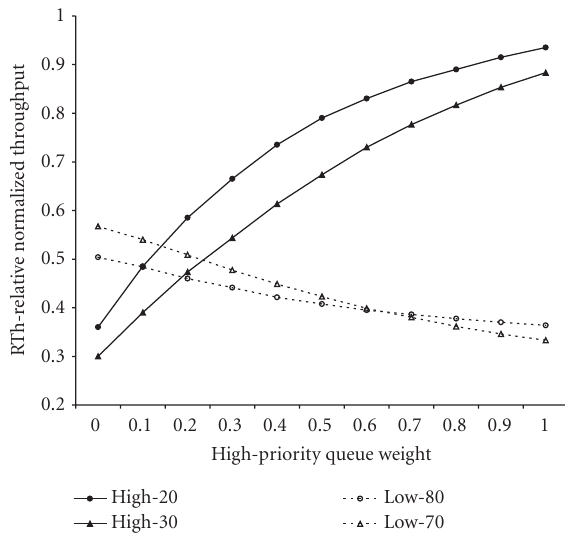
Figure 6: Normalized throughput for di ff erent priority classes un- der varying high-priority queue weights and full load.